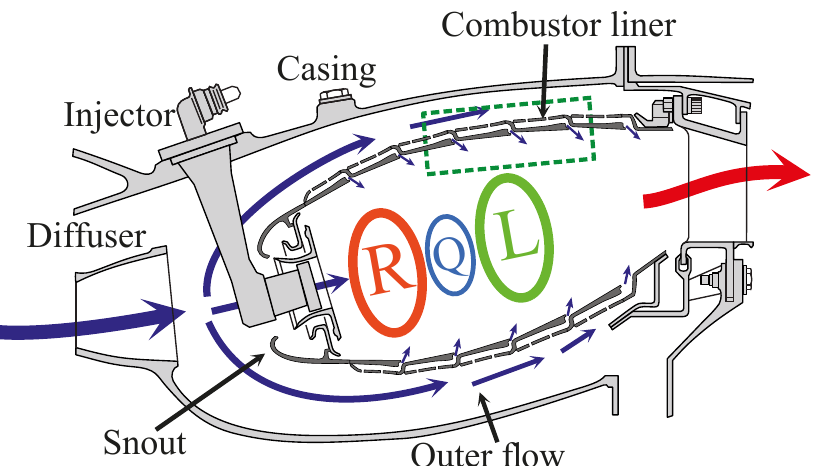
Figure 1. Double-wall design study adapted from V2500 combustor. The compressed air (blue) is divided between the combustor liner and outer flow. The air in the outer flow acts as mixing air and coolant, while the combustor liner air is used for primary combustion (red). Green area marks the region of interest for this study with focus on the cavity between the two liner